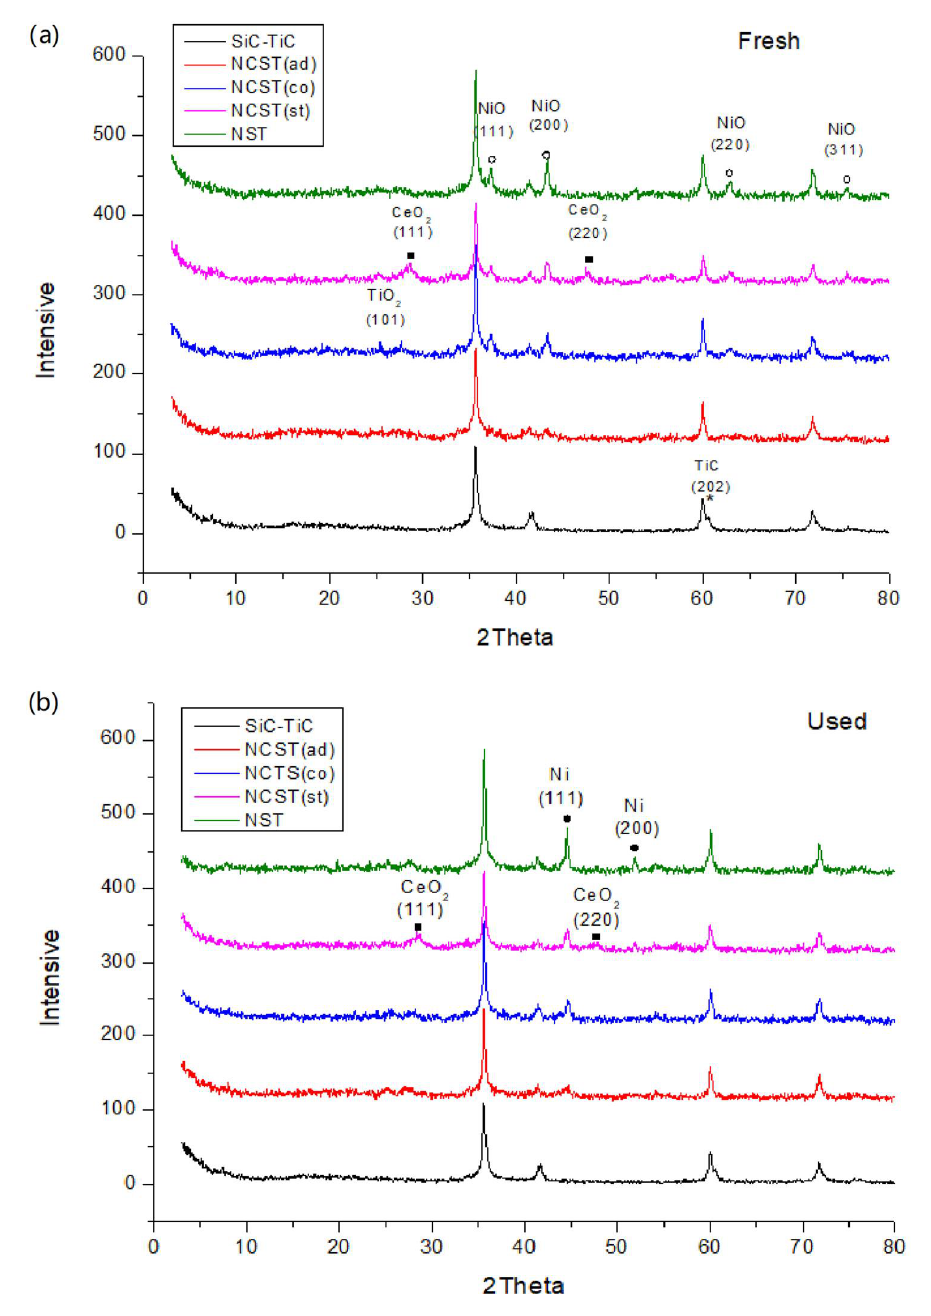
Figure 4. XRD patterns of ( a ) fresh (before reduction) and ( b ) used catalysts. Table 2. Crystallite size calculated by the Scherrer equation.